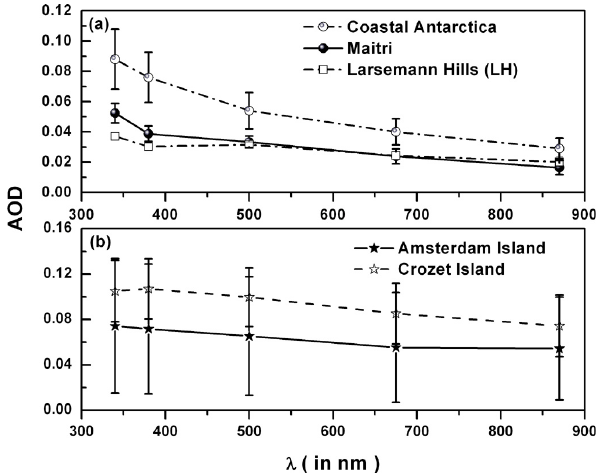
Fig. 5. (a) Mean AOD spectrum for the entire period at Maitri and Larsemann Hills along with the CAO region where open sphere, solid sphere and open square corresponds to CAO, Maitri and LH, respectively. The vertical line passing through the symbol repre- sents the standard deviation from the mean value. (b) Spectral vari- ation at Amsterdam (represented by solid star) and Crozet Island (represented by open stars). The vertical line passing through the symbols are the standard deviation from the mean value.